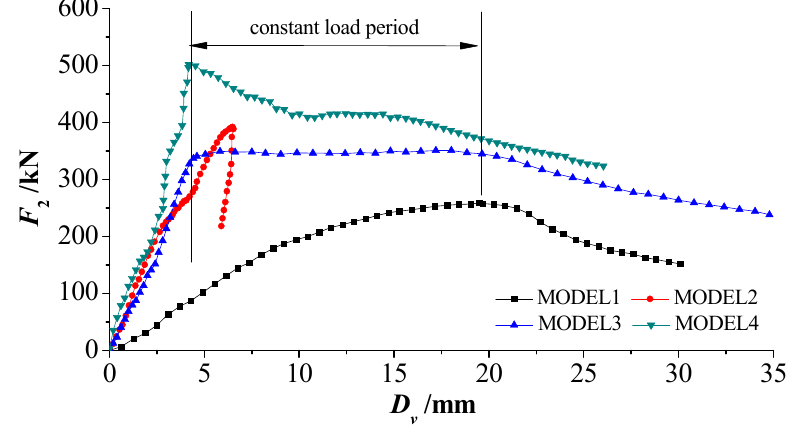
Figure 12. Relationships between vertical load F 2 and displacements D v in bottom arch. Table 3. MBC and vertical stiffness in bottom arch.